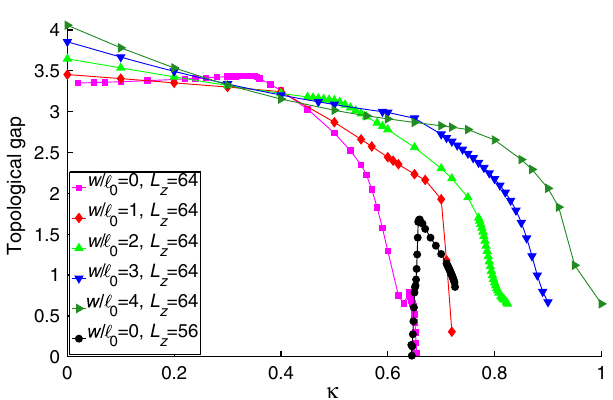
FIG. 8. The topological gap, the difference between the universal and lowest generic level at L A z ¼ 64 , is calculated in spherical geometry at S ¼ 3 for the system with N Φ ¼ 29 . Note that qualitatively the behavior and collapse of the topological gap are similar to the collapse of the overlaps shown in Fig. 5. We also show the topological gap at L A z ¼ 56 (filled black circles) in the region of parameter space where the entanglement spectrum qualitatively changes and has the same chirality as the aPf state (see the κ ¼ 0 . 66 panel in Fig. 7).